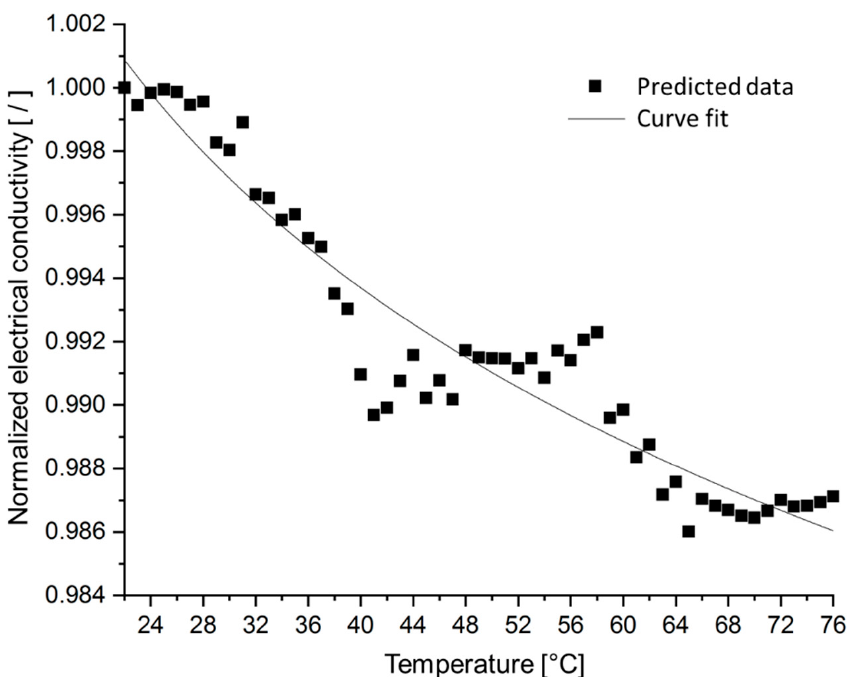
Figure 18. Normalized electrical conductivity, considering only thermal expansion effects, versus temperature for silver/epoxy nanocomposites with a particle size of 3 nm, tunneling distance of 1.5 nm, and filler loading of 30 vol%.